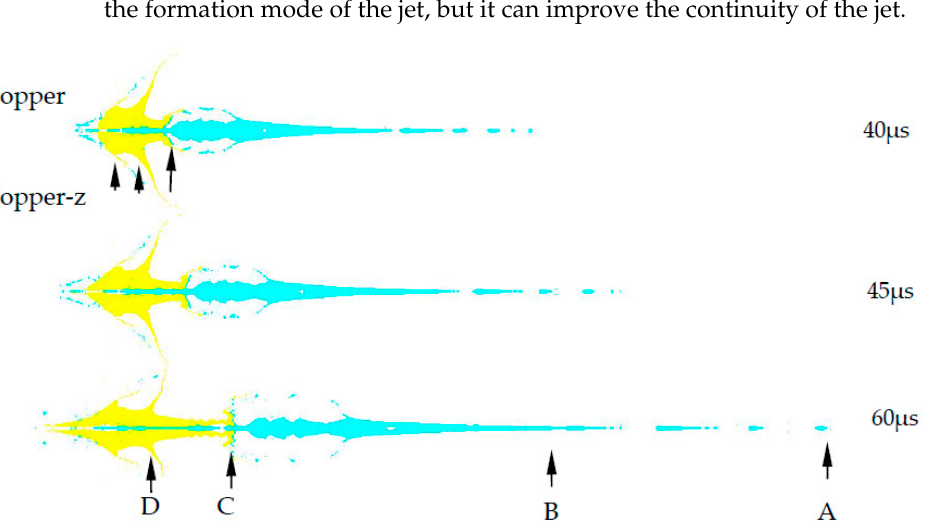
Figure 6. Jet shape: ( a ) composite charge; ( b ) integrated charging.